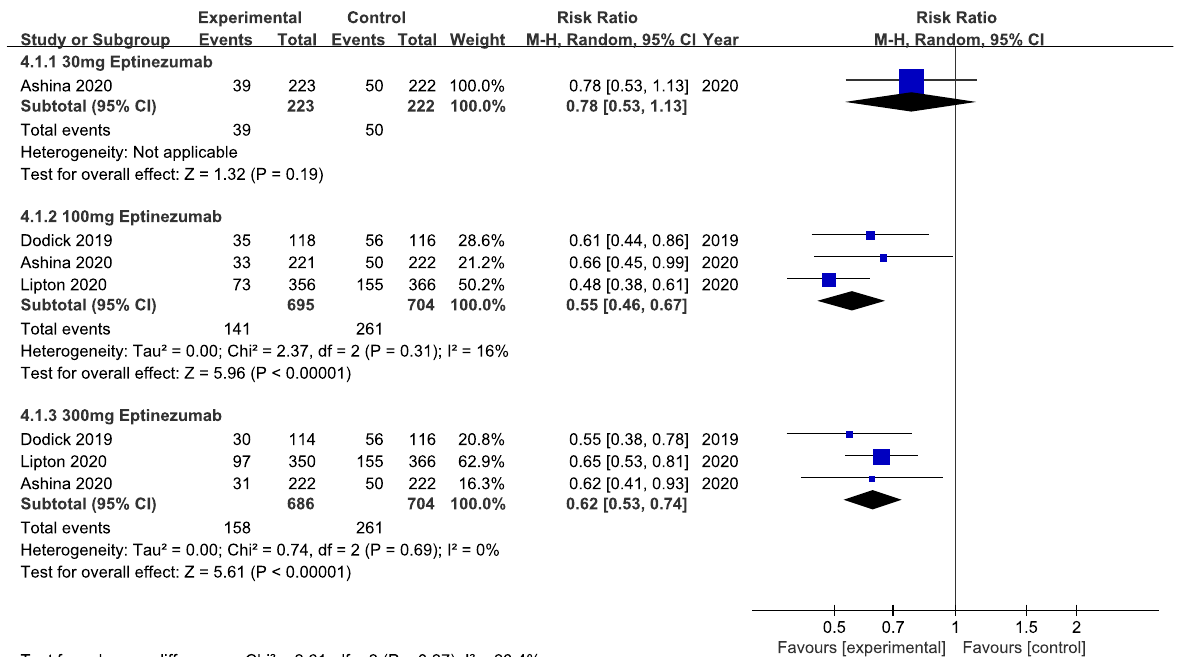
Fig. 5 The pooled risk ratio (RR) of patients with migraine 1 day after dosing in different treatment doses compared with placebo, the diamond indicates the estimated RR with 95% confidence interval (CI) for the pooled